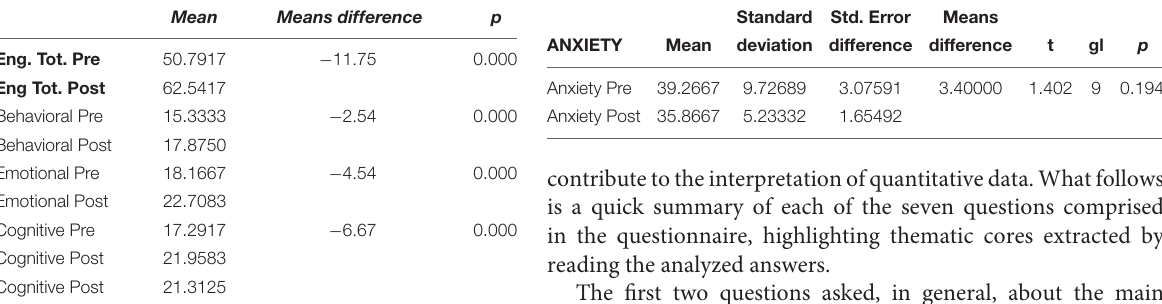
Standard Std. Error